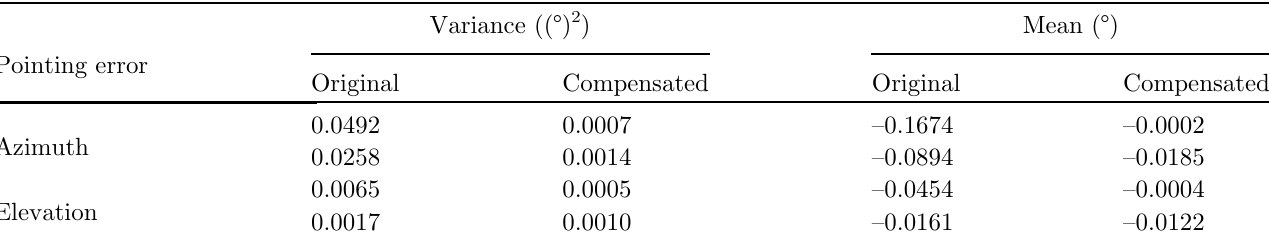
Fig. 4. Prediction results for the test data. Table 1. Compensation results comparison.